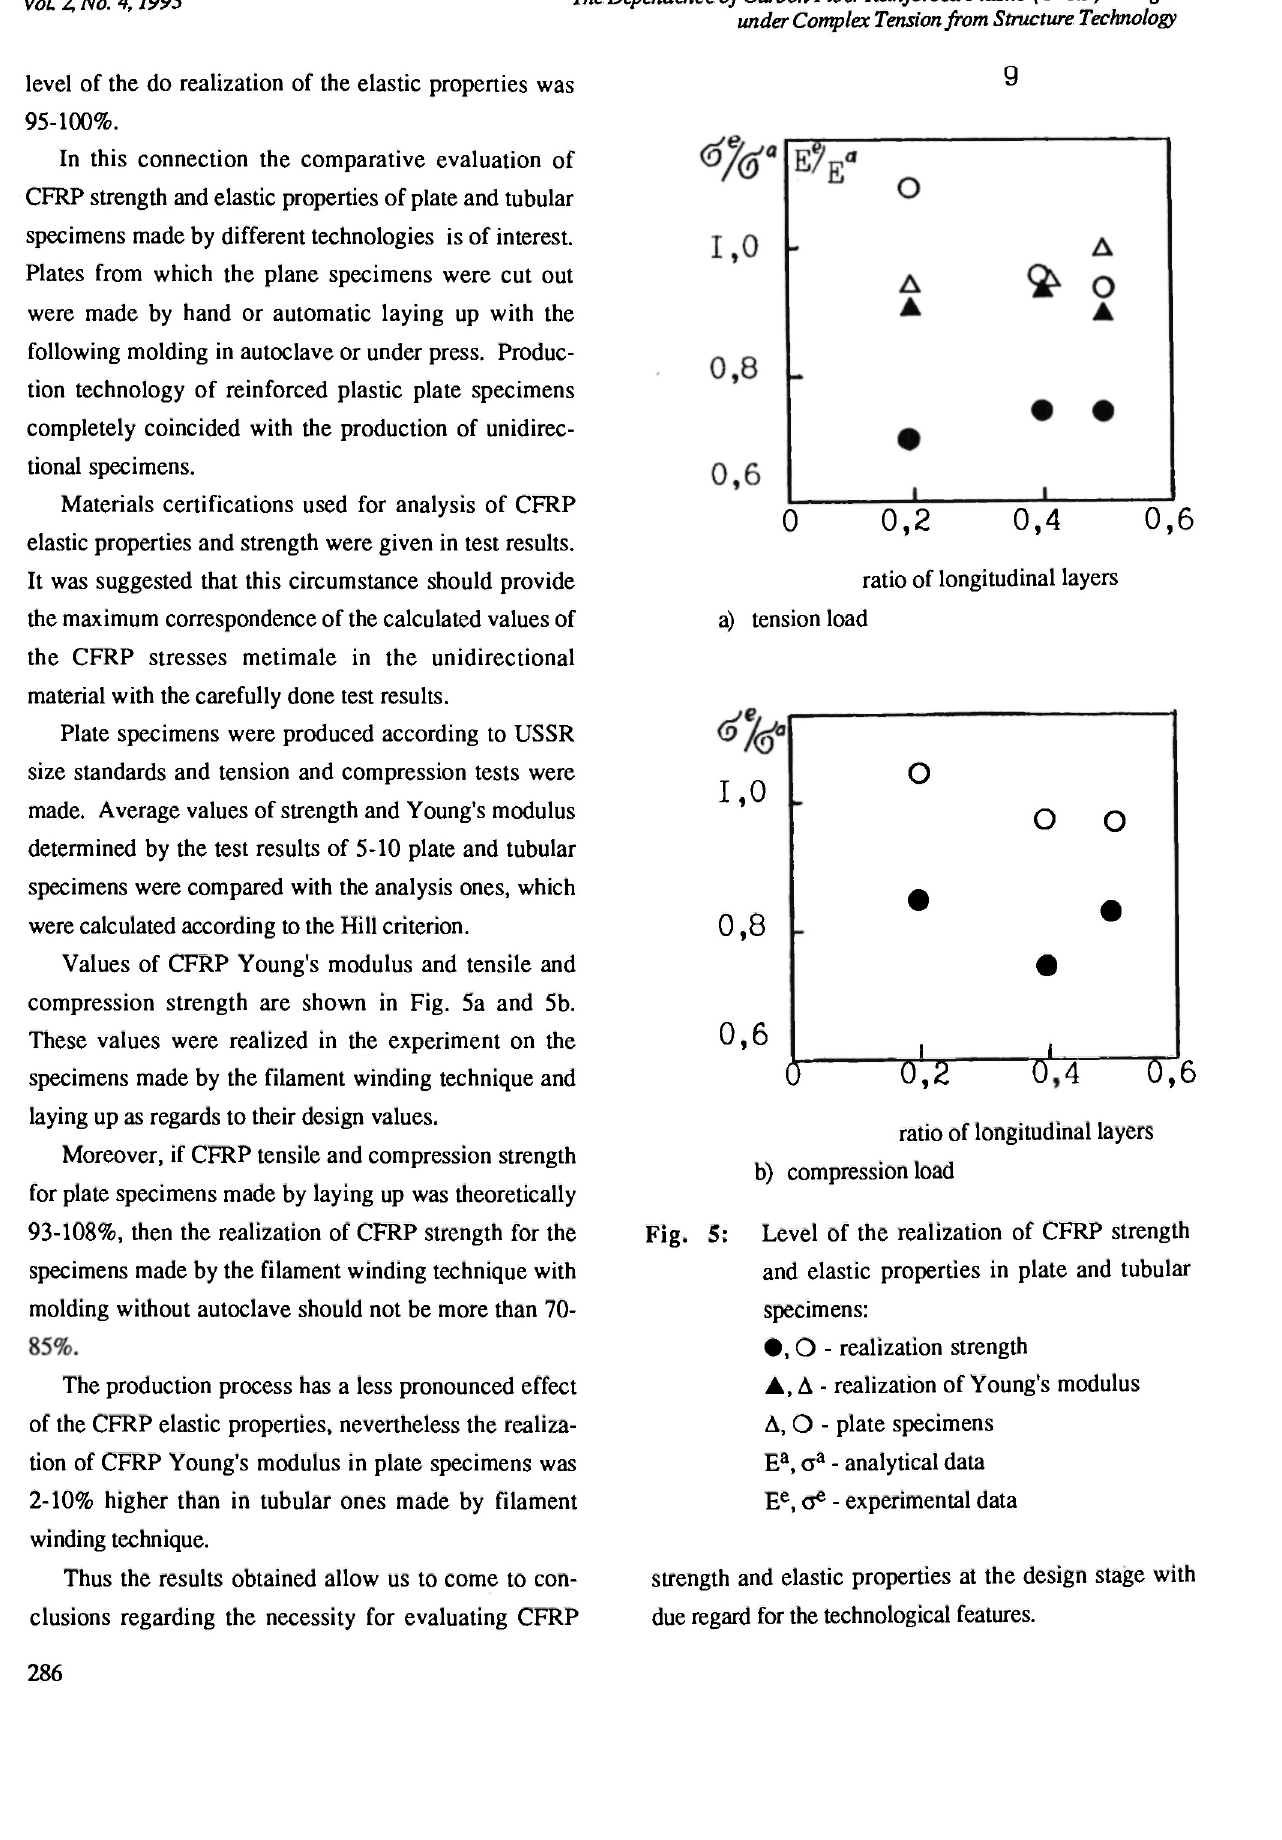
ratio of longitudinal layers b) compression load Level of the realization of CFRP Fig. 5: